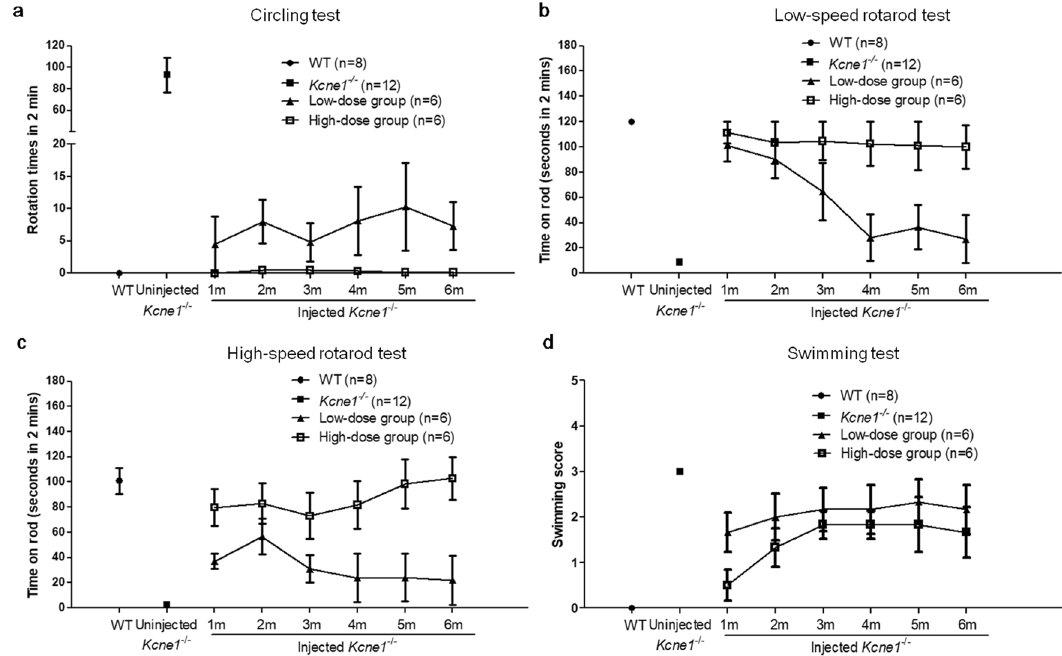
Fig. 7 Examinations on the vestibular functions of the WT, untreated, and low- and high-dose-treated Kcne1 − / − mice measured at 1 – 6 months after injections ( n ≥ 6 in each group). a Changes in the number of rotations of in WT, untreated, and low- and high-dose-injected Kcne1 − / − mice as indicated by the fi gure legends. Data are shown as mean ± SEM. Source data are provided as a Source data fi le. b Changes in rotarod performance (low-speed tests) of WT, untreated, and low- and high-dose-injected Kcne1 − / − mice. Data are shown as mean ± SEM. Source data are provided as a Source data fi le. c Changes in rotarod performance (high-speed tests) of WT, untreated, and low- and high-dose-injected Kcne1 − / − mice. Data are shown as mean ± SEM. Source data are provided as a Source data fi le. d Changes in swimming scores of WT, untreated, and low- and high-dose-injected Kcne1 − / − mice. Data are shown as mean ± SEM. Source data are provided as a Source data fi